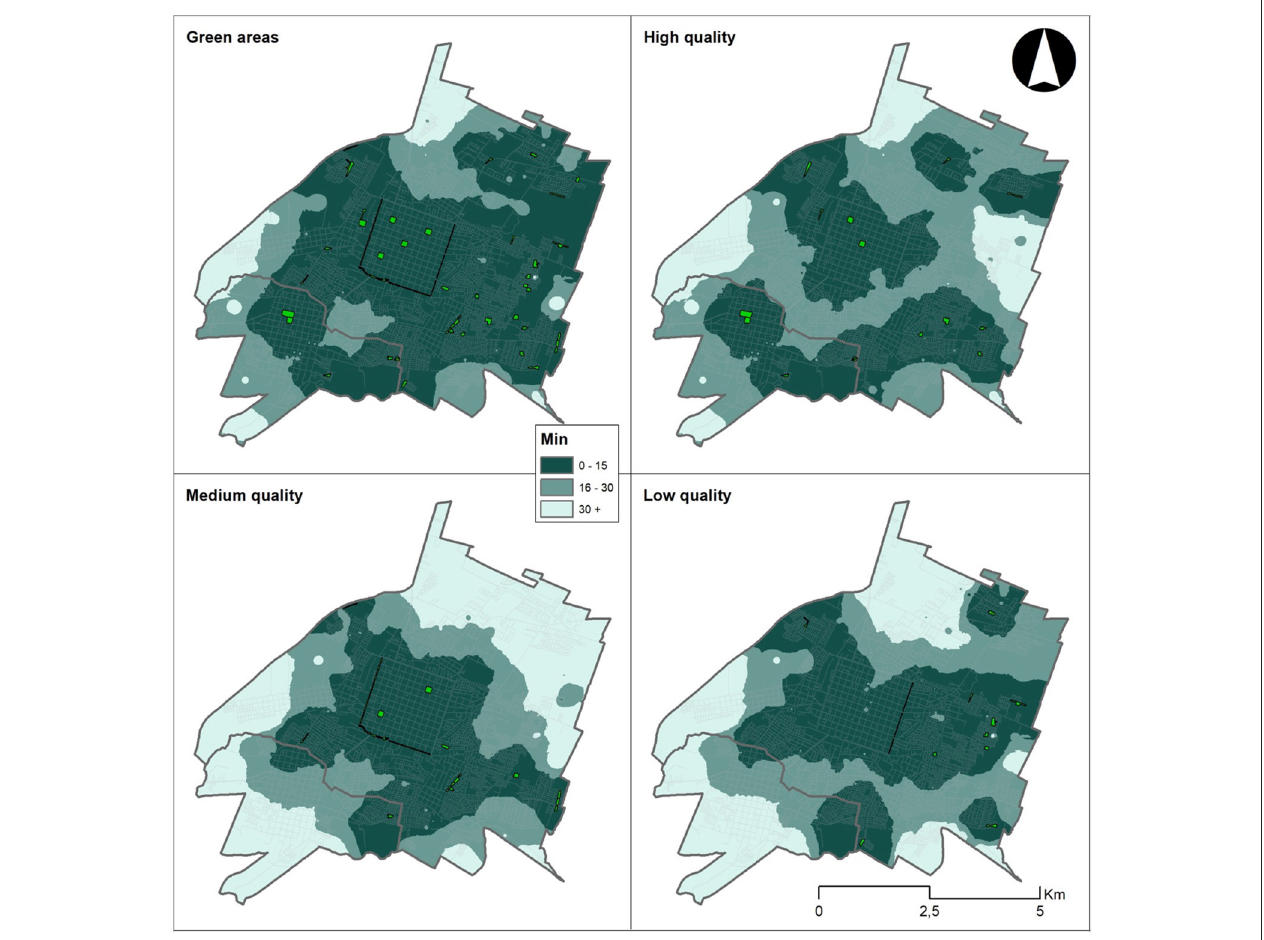
FIGURE 6 | Accessibility of urban green spaces in Chillán, for all green areas (top left), and according to quality